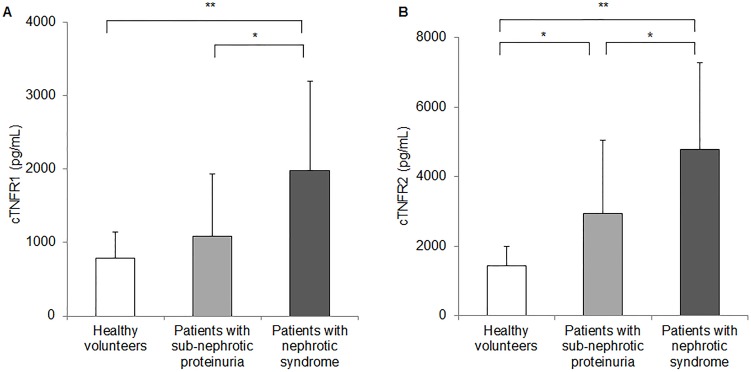
Circulating TNFRs levels in the patients with iMN compared with those in the healthy volunteers.**P<0.001, *P<0.05.